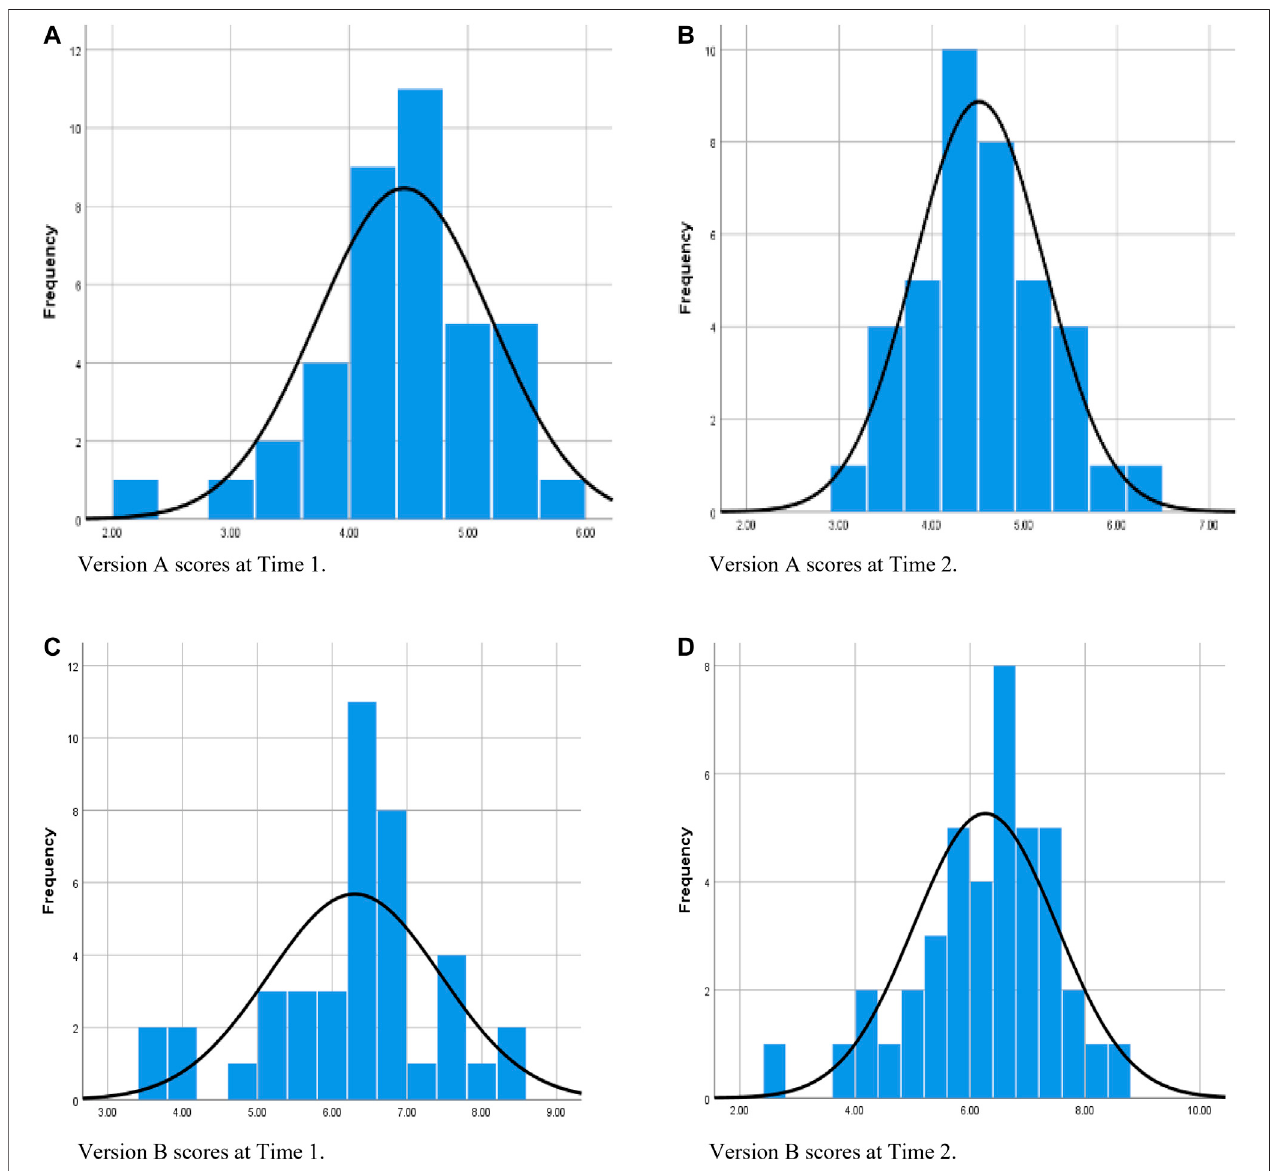
FIGURE 1 | Distribution of composite scores on each version on each occasion of measurement prior to winsorizing